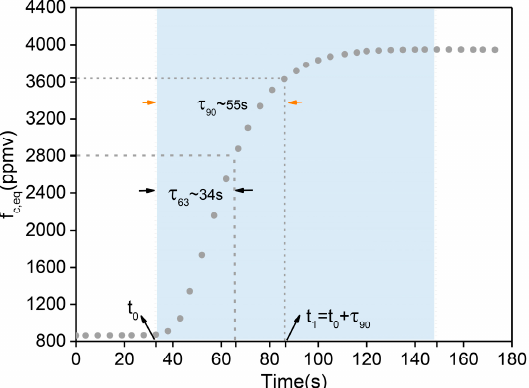
Figure 6. Typical response of the system in conjunction with a home-made sample extraction device whilst the reaction reagent was added to the analyzed water sample at t 0 . τ 90 and τ 63 were the times taken for the signal to reach 90% and 63% of the final concentration span, respectively. The blue area was the whole rising process from background concentration to maximum concentration.